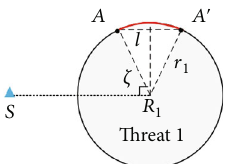
Figure 14: The boundary docking point on the same associated